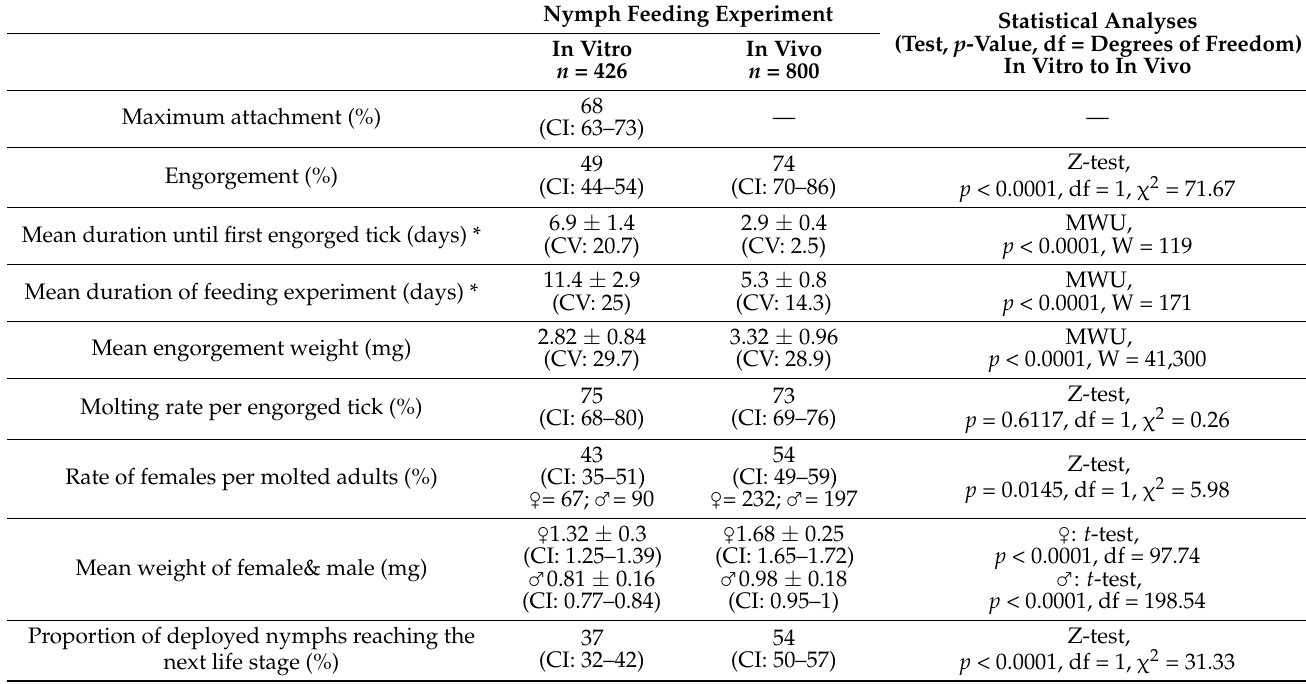
Table 3. Artificial feeding of I. ricinus nymphs. Nymph Feeding Experiment Statistical Analyses (Test, p -Value, df = Degrees of Freedom) VivoIn Vitro In Vivo In Vitro to In n = 426 n =